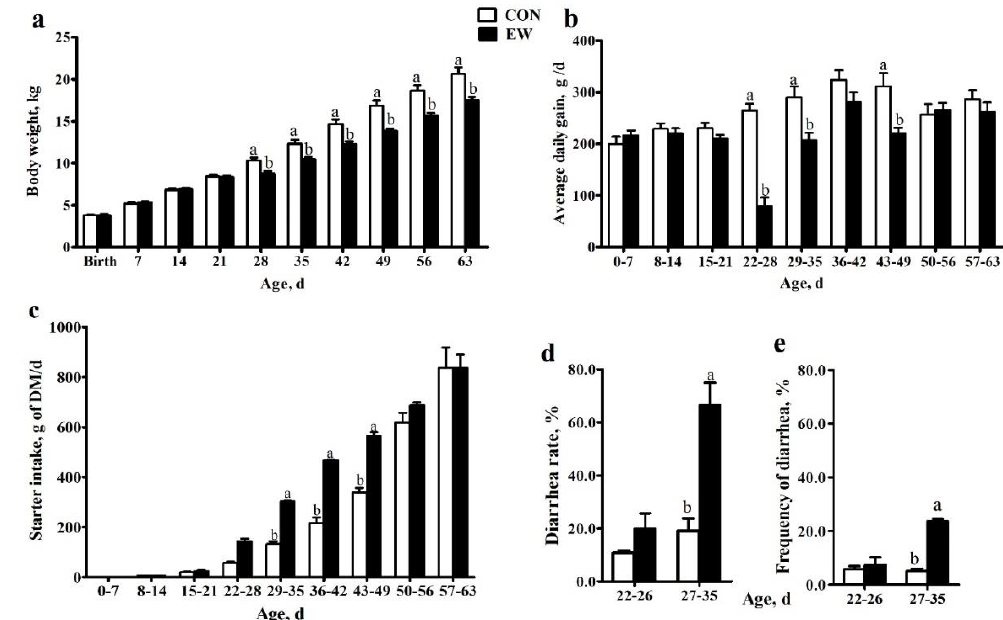
Figure 1. Body weight ( a ), average daily gain ( b ), starter intake ( c ), and diarrhea rate ( d , e ) for lambs weaned at day 21 as early weaned group (EW; black columns) or lambs weaned at day 49 as conventional weaned group (CON; white columns). Columns with different letters at a single time point indicate means that differed based on the means separation ( p < 0.05). Error bars indicate SEM for the treatment × age interaction.